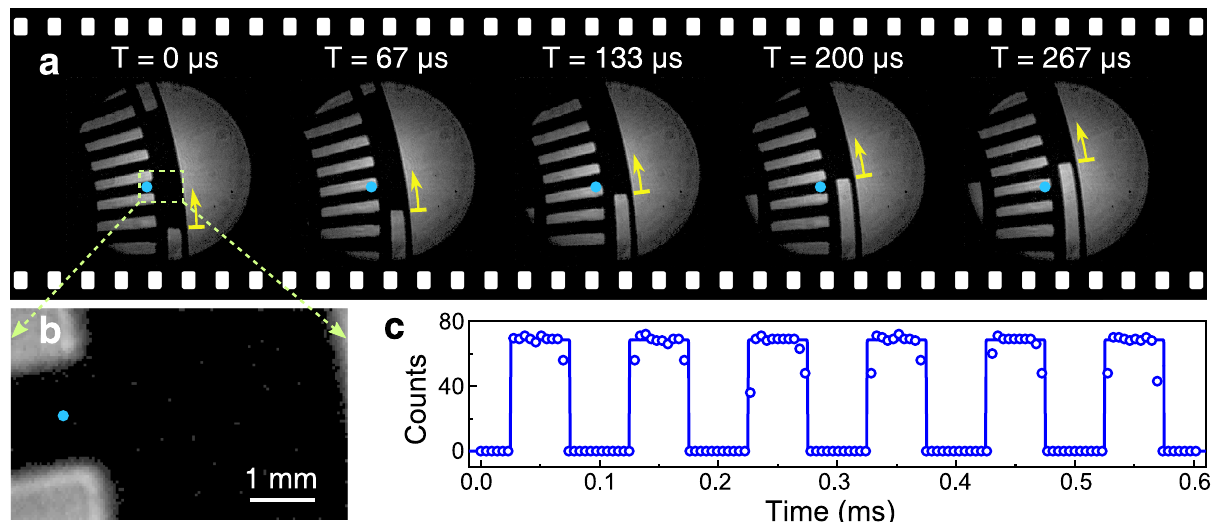
Fig. 6 MIR imaging at high frame rates. a Videography at 15,000 frames per second for a rapidly rotating chopper. The outermost slot rotates at a speed up to 31.4 m/s. b Video-shooting with a reduced frame size to support a faster frame rate up to 216,000 fps. c Temporal evolution of the intensity at the pixel denoted by a dot. The measured period of 0.1 ms is consistent with the 10-kHz angular frequency speci fi ed for the investigated slot. Note that all the images are acquired by a high-speed CMOS camera with an exposure time of 1.05 μ s. The recorded videos are given in Supplementary Movie